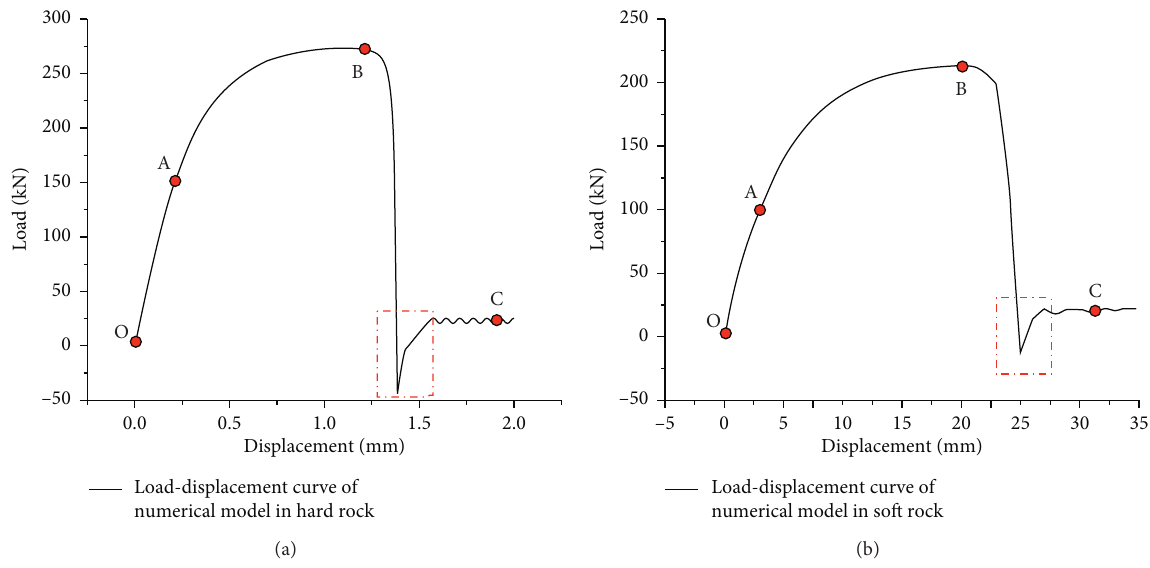
Figure 10: Load-displacement curves of numerical model (a) in hard rock and (b) soft